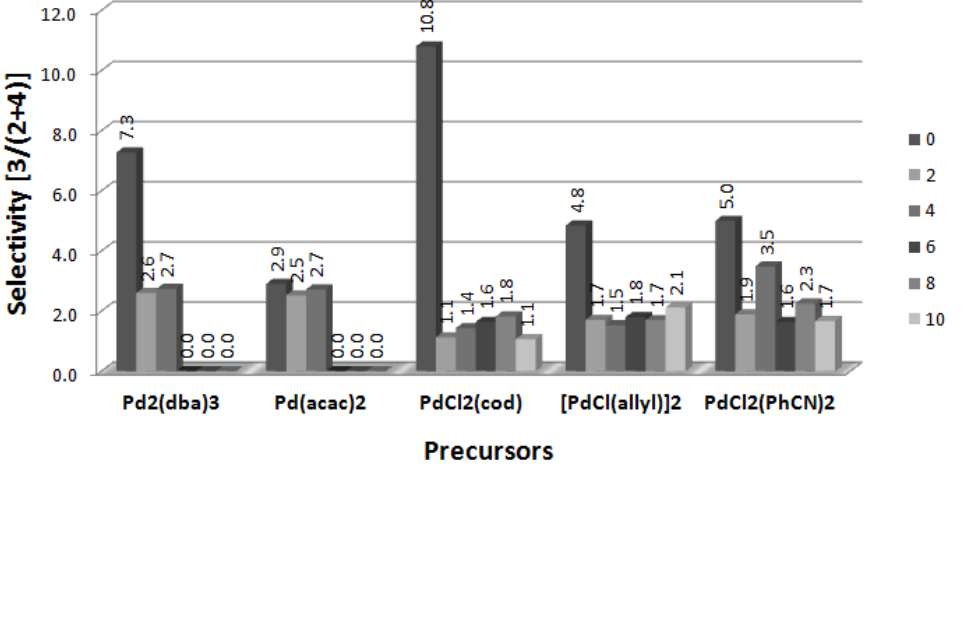
Figure 2. Effect of [CIL]:[Pd] ration on selectivity of Heck arylation of DHF. CIL =